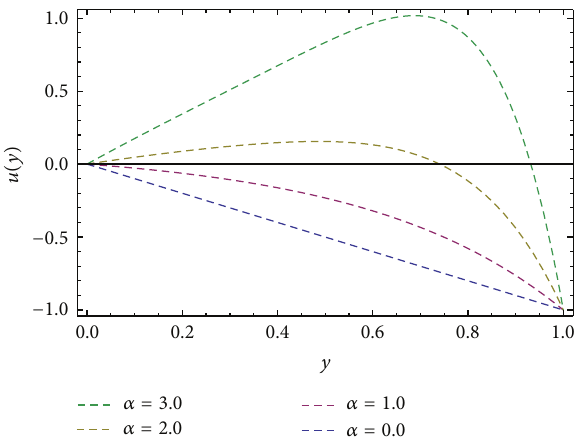
Figure 2: Velocity profile 𝑢(𝑦) for different values of 𝛼 , keeping 𝜕𝑃/𝜕𝑥 = −0.5 , 𝛽 = 1.0 , and 𝜙 = 45 ∘